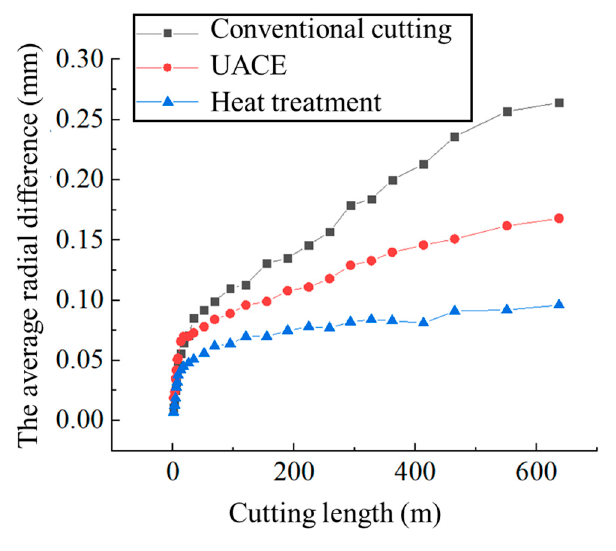
Figure 12. The average radial difference of different disc cutters.